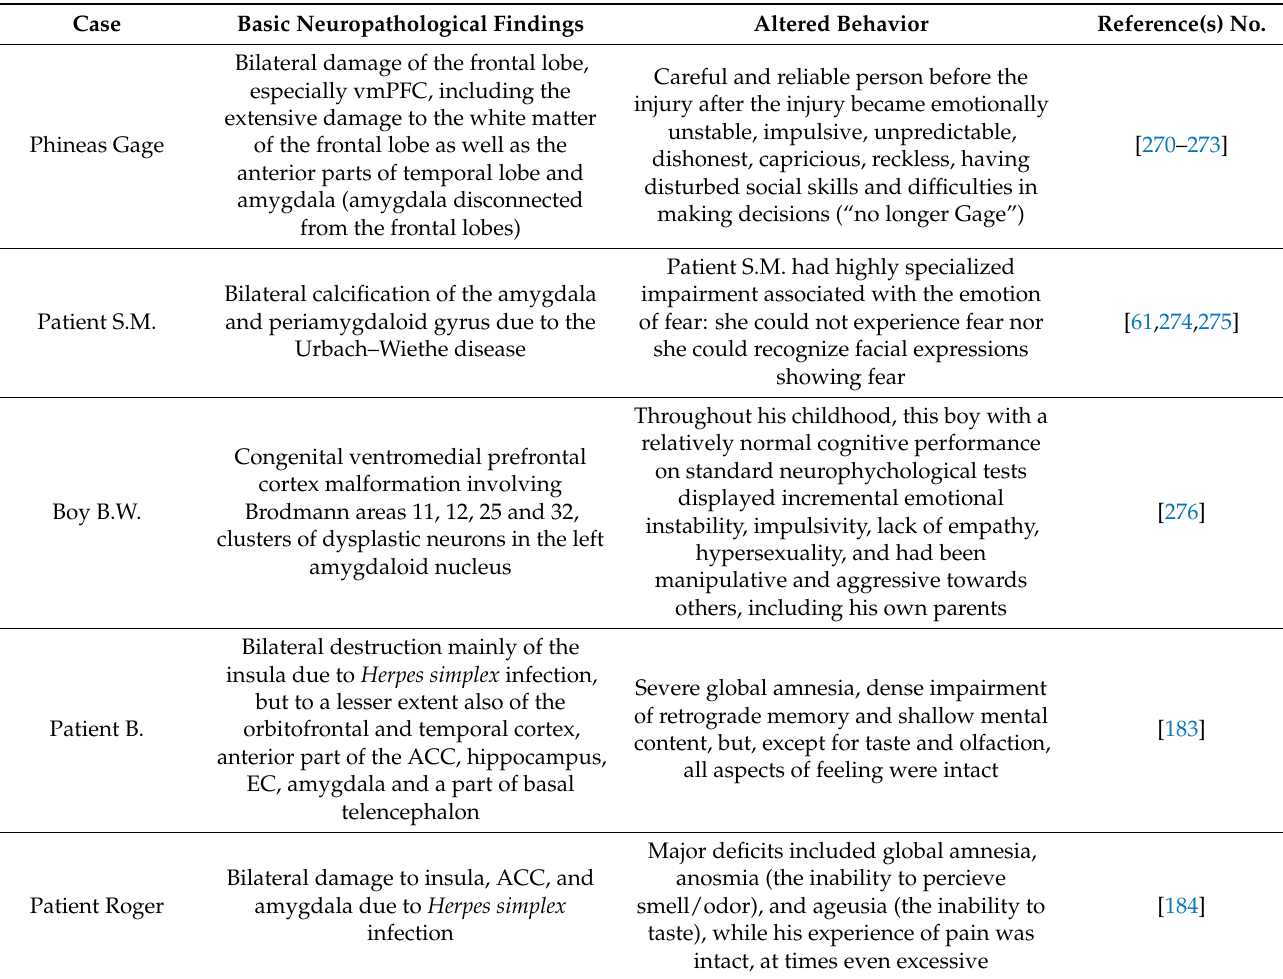
Table 2. Selected clinical cases of disturbed emotional experience and behavior. See text for details. Case Basic Neuropathological Findings Altered Behavior Reference(s)